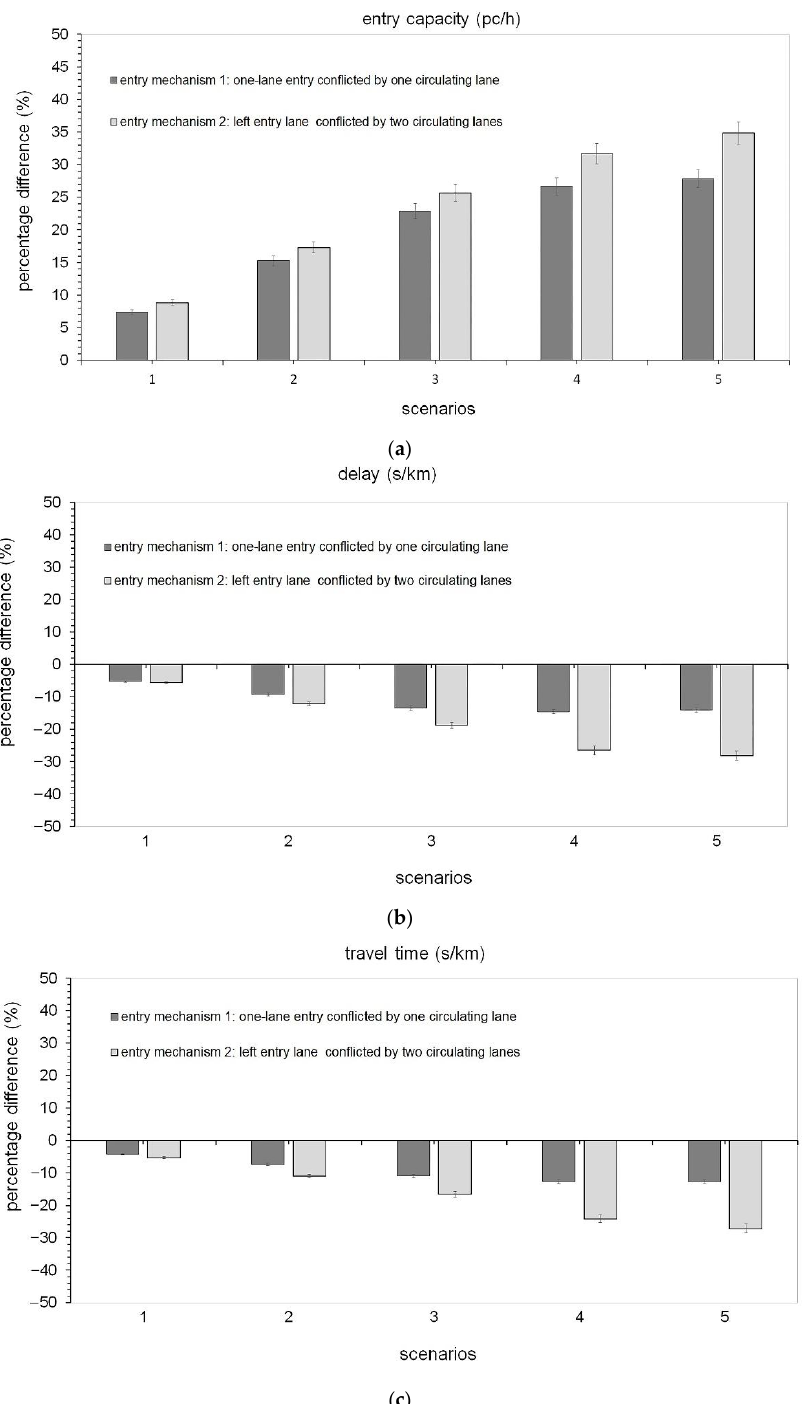
Figure 9. Percentage differences in the “what-if” scenarios compared to the baseline scenario with HDVs only: ( a ) entry capacity, ( b ) delay and ( c ) travel time. Note: (1) 20% CAVs vs. baseline scenario; (2) 40% CAVs vs. baseline scenario; (3) 60% CAVs vs. baseline scenario; (4) 80% CAVs vs. baseline scenario; (5) 100% CAVs vs. baseline